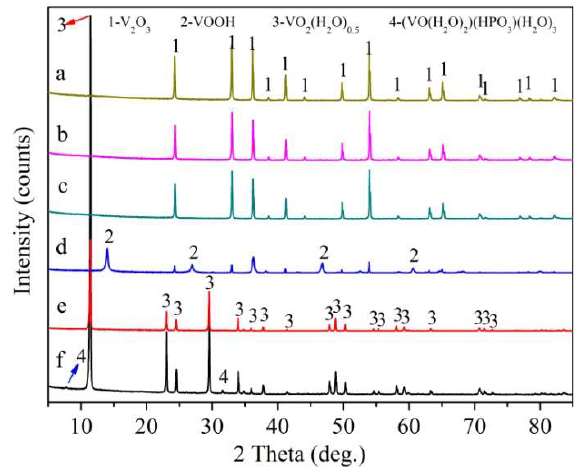
Figure 7. XRD patterns of the precipitates obtained at different P concentrations of ( a ) 0.05 g/L; ( b ) 0.29 g/L; ( c ) 0.5 g/L; ( d ) 1 g/L; ( e ) 1.48 g/L and ( f ) 3 g/L in the feed solutions.